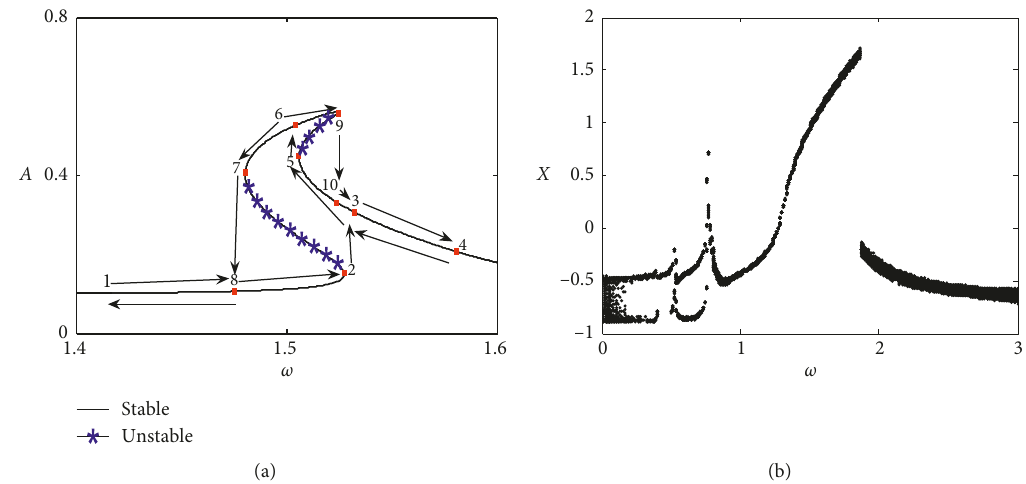
Figure 10: Nonlinear responses of the vibration system: (a) amplitude-frequency curves and (b) bifurcation diagram.